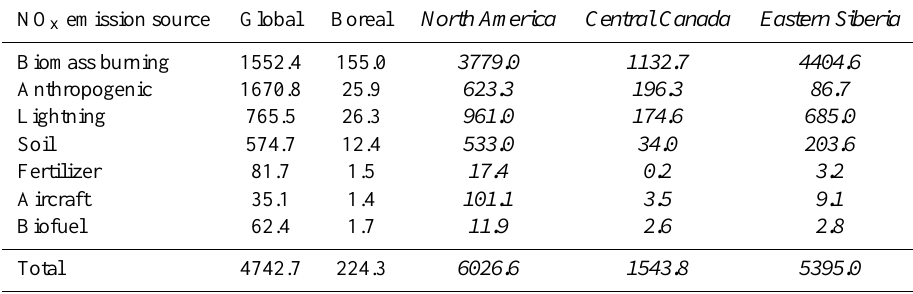
Table 3. Total NO x emissions over the BORTAS-A campaign period (12 July to 4 August 2010) in units of Gg N. Values in italics have units of 10 − 3 Gg